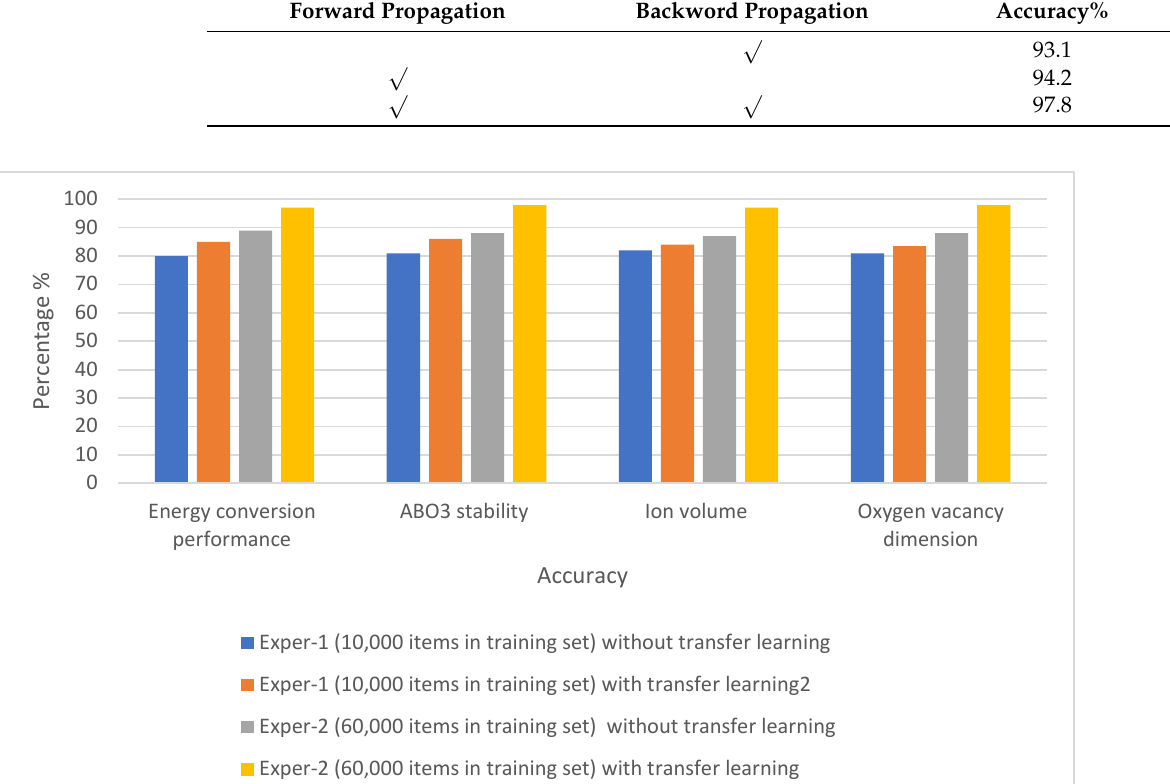
Figure 10. Classification accuracy rate for the four output LSCD classes.